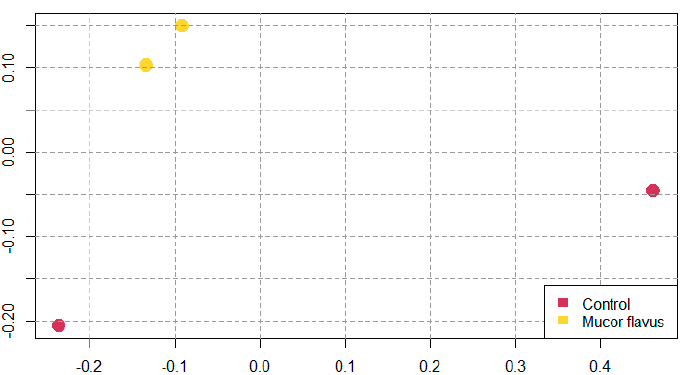
Figure 6. PCoA plot based on Bray–Curtis dissimilarity measure showing the variation of ASV communities from different meat samples.